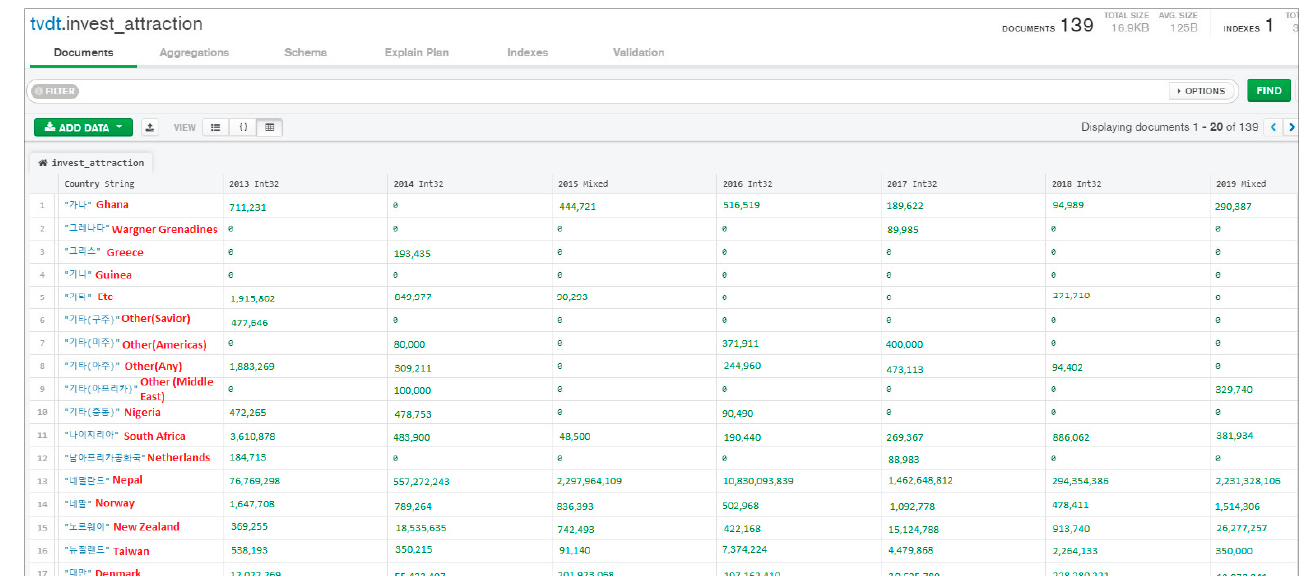
Figure 21. Metadata of Invest attraction data.